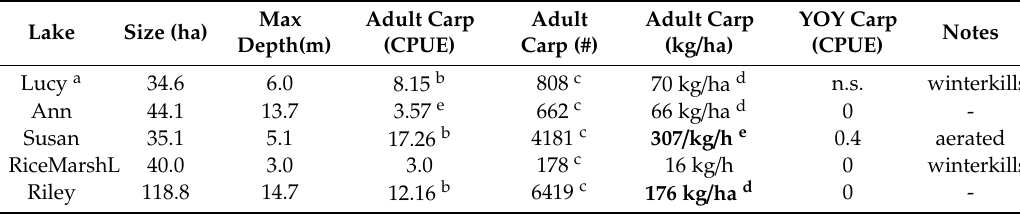
Figure 6. The Riley Chain of Lakes. Table 5. Lakes in the Riley Chain of Lakes and their carp in 2008–2009. Data on carp densities are described in the text (emboldened values are for adult densities that are ecologically